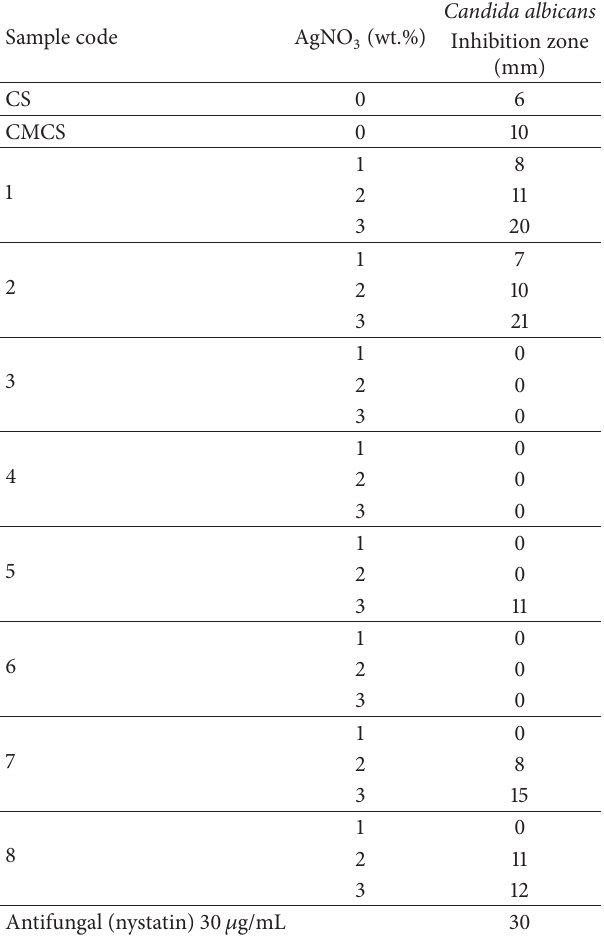
Table 4: Antifungal activities of CS or CMCS/Schiff-base/AgNPs. Sample